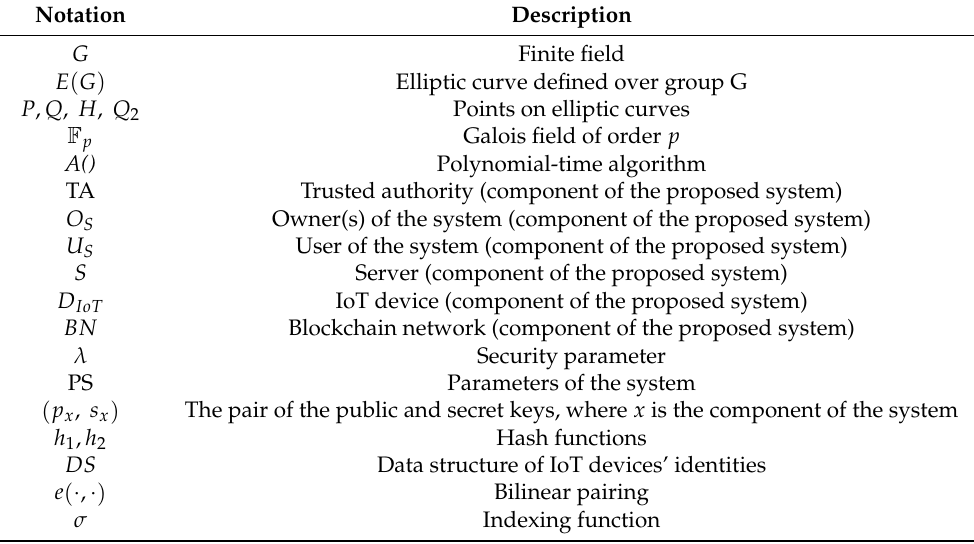
Table 1. Notations